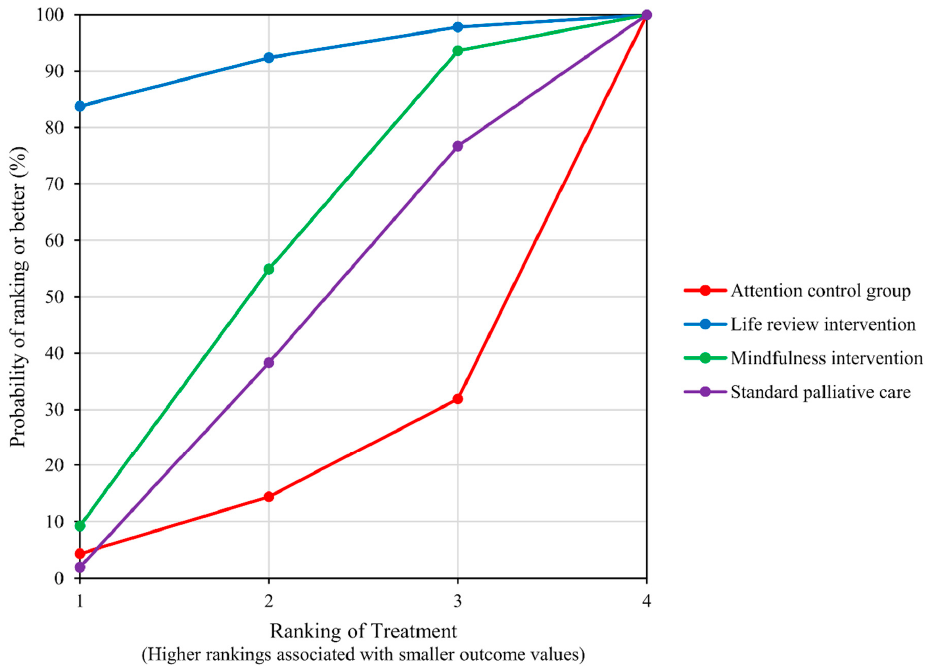
Figure 9. SUCRA plot for outcome of Distress.